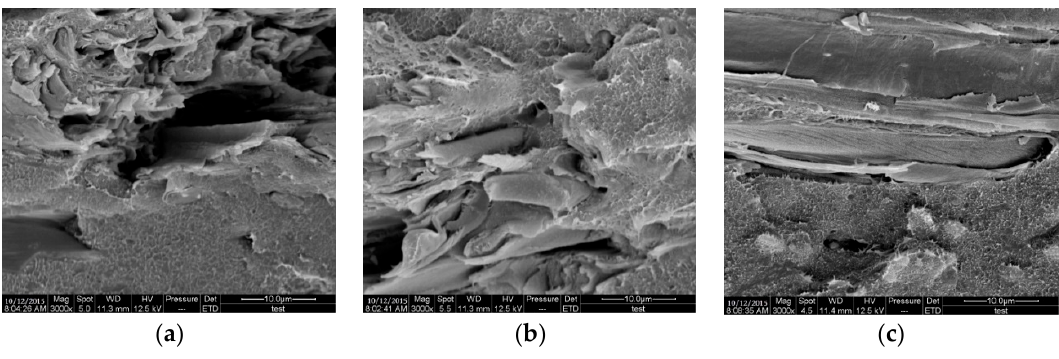
Figure 5. The scanning electron microscope (SEM) photograph of ( a ) GF/PF composites; ( b ) GF/20%-BPF composites; ( c ) GF/40%-BPF composites.